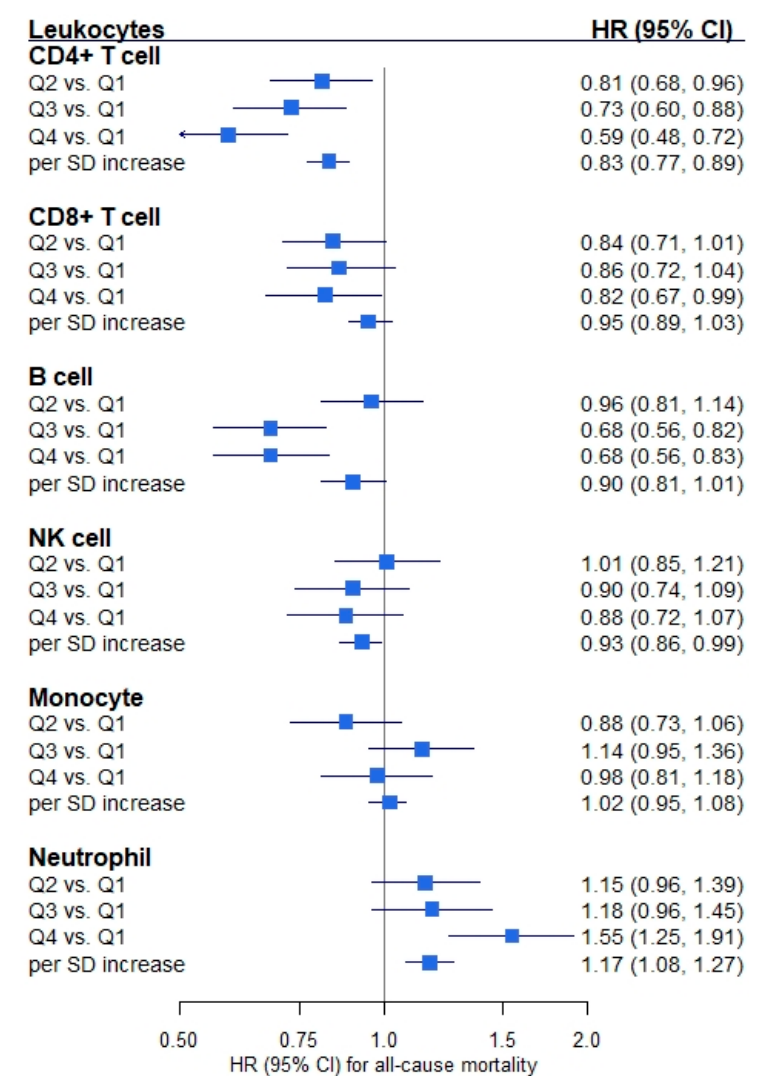
Figure 1. Forest plot of the associations between leukocyte composition and all-cause mortality. Note: Hazard ratio (HR) and 95% confidence interval (CI) were derived from Cox regression model adjusting for age, sex, tumor stage, tumor subsite, timing of blood sampling and batch ( n patients = 2194, n deaths = 1071). An HR of one means that there is no difference in survival between the two groups. Abbreviation: Q1–Q4, quartile 1 (lowest)–quartile 4 (highest); SD, standard deviation.